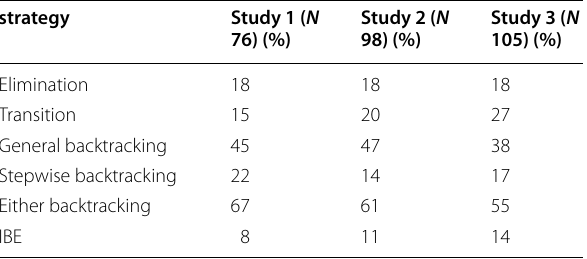
Table 2 Percentages of participants who used strategies